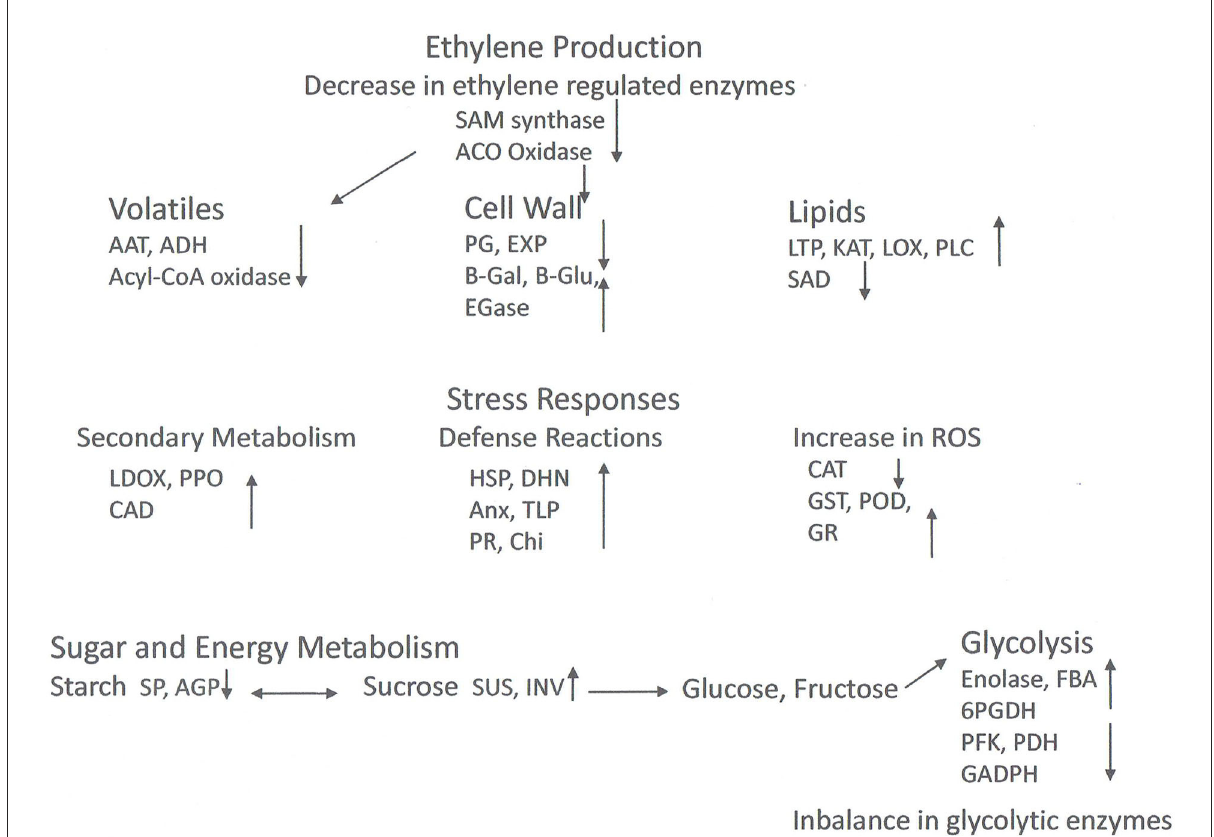
FIGURE2 Model of proteomic changes in cellular processes that occur during chilling injury development in peaches and nectarines. Inhibition of ethylene synthesis in the cold affects processes including cell wall modulation and volatile production. The cold stress induces stress responses including phenol and flavonoid production, and biotic and abiotic stress compounds. Antioxidative enzymes are induced (except for catalase), but ROS accumulates nonetheless. Sucrose reserves decrease. Enzyme levels of glycolysis are both high and lower fruit without cold storage, suggesting an imbalance in activity. Abbreviations: AAT, Alcohol acyl transferase; ACO oxidase, 1-aminocyclopropane-1-carboxylic acid oxidase; ADH, alcohol dehydrogenase; AGP, glucose pyrophosphorylase; Anx, annexin; CAD, cinnamyl alcohol dehydrogenase; CAT, catalase; CHI, chitinase; DHN, dehydrin; EGase, endo-1,4-beta-D-glucanases; EXP, expansin; FBA, fructose bisphosphate aldolase; GADPH, glyceraldehyde 3 phosphate dehydrogenase; B-Gal, β -galactosidase; B-glu, β -glucanase; GR, glutathione reductase; GST, glutathione S-transferase; HSP, heat shock protein; INV, invertase; KAT, 3-ketoacyl-CoA-thiolase; LDOX, leucoanthocyanidin oxidase; LOX, lipoxygenase; LTP, lipid transfer protein; PFK, 6-phosphofructokinase; PDH, pyruvate dehydrogenase; PG, polygalacturonase; 6PGDH, 6-phosphogluconate dehydrogenase; PLC phospholipase C; POD, peroxidase; PPO, polyphenoloxidase; SAD, steroyl-ACP-desaturase; SAM oxidase, S-adenosylmethionine oxidase; SP, starch phosphorylase; SUS, sucrose synthase; TLP, thaumatin like